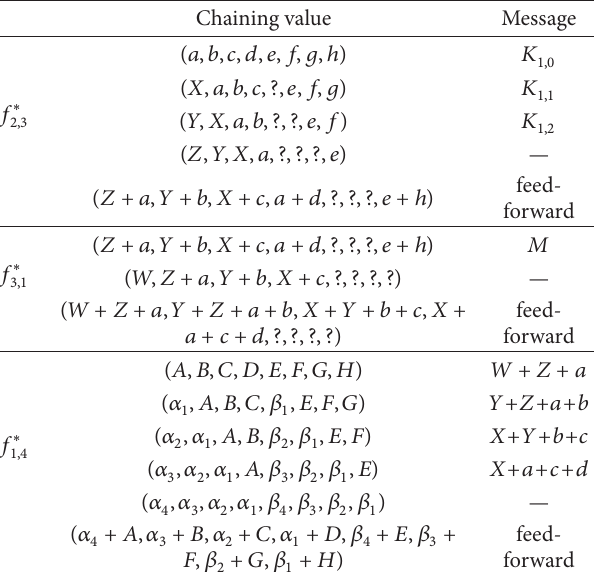
Table 3: Recovery of (𝐾 1,0 ,𝐾 1,1 , 𝐾 1,2 ) . Chaining